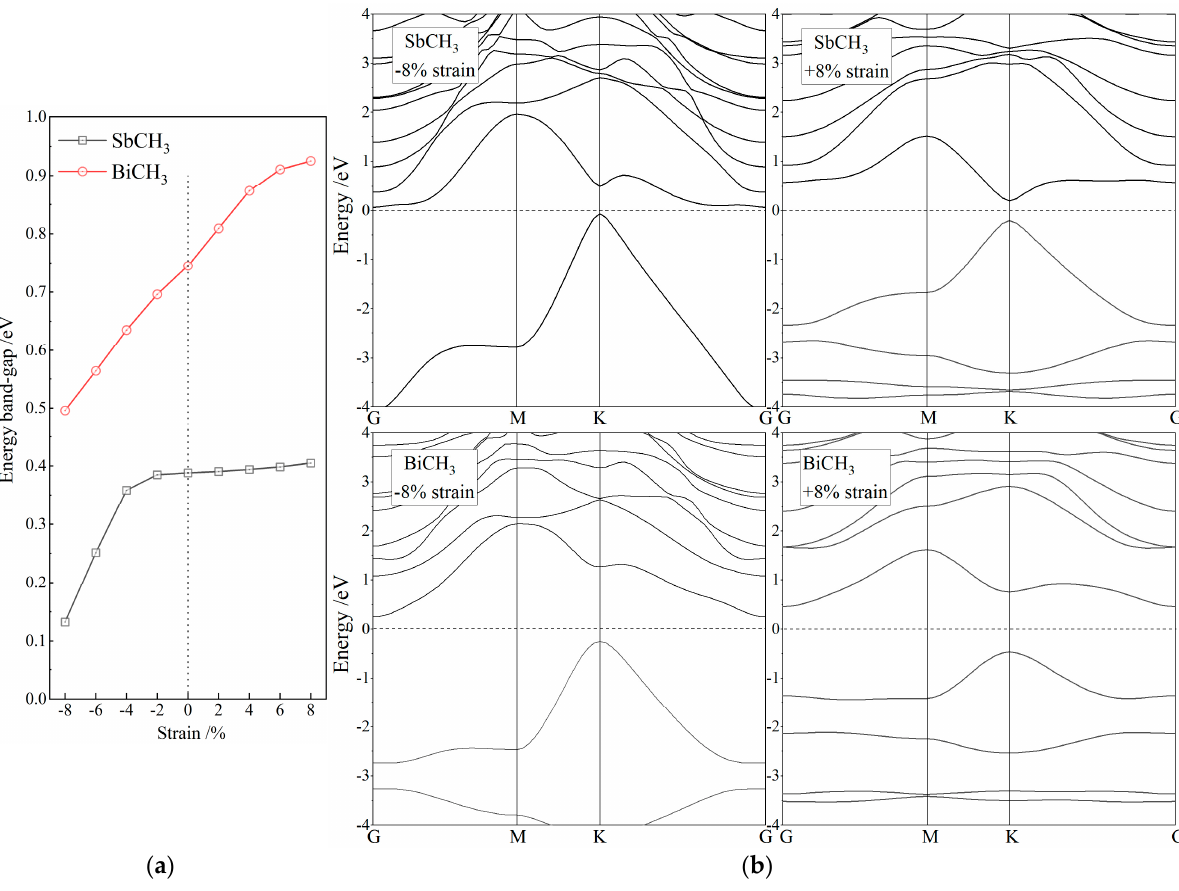
Figure 5. ( a ) Global bulk band-gaps in dependence on bi-axial strains of − 8~8% and ( b ) band structures under ±8% bi-axial strains for SbCH 3 and BiCH 3 , which are calculated with SOC included.